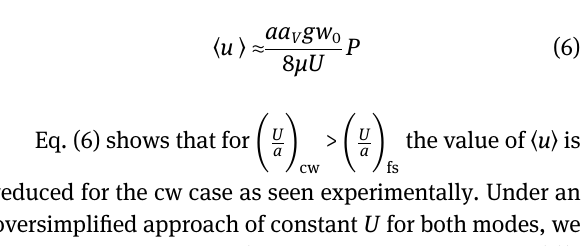
Accounting also for a cw ∼ 1 . 15 a fs , we fi nd through Eq. (6) ∼ 1 . 31 ( U ) that ( U ) , showing that the overall heat trans- cw fs fer coef fi cient in the fs case is signi fi cantly lower. Notably, for P ≥ 80 mW, the h convection coef fi cient in principle increases due to its dependence on local δ Τ [35], however, at a different rate between the two modes as shown in Figure 10. For P < 80 mW, it is almost zero, so that 〈 u 〉 ≈ 〈 u 〉 cw fs